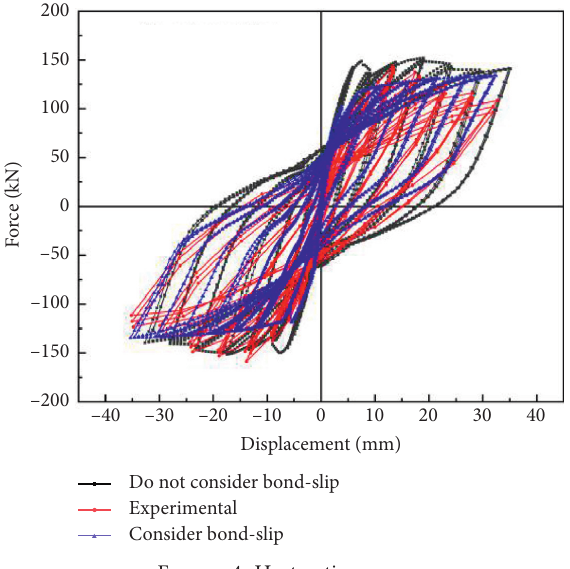
Figure 4: Hysteretic curve.